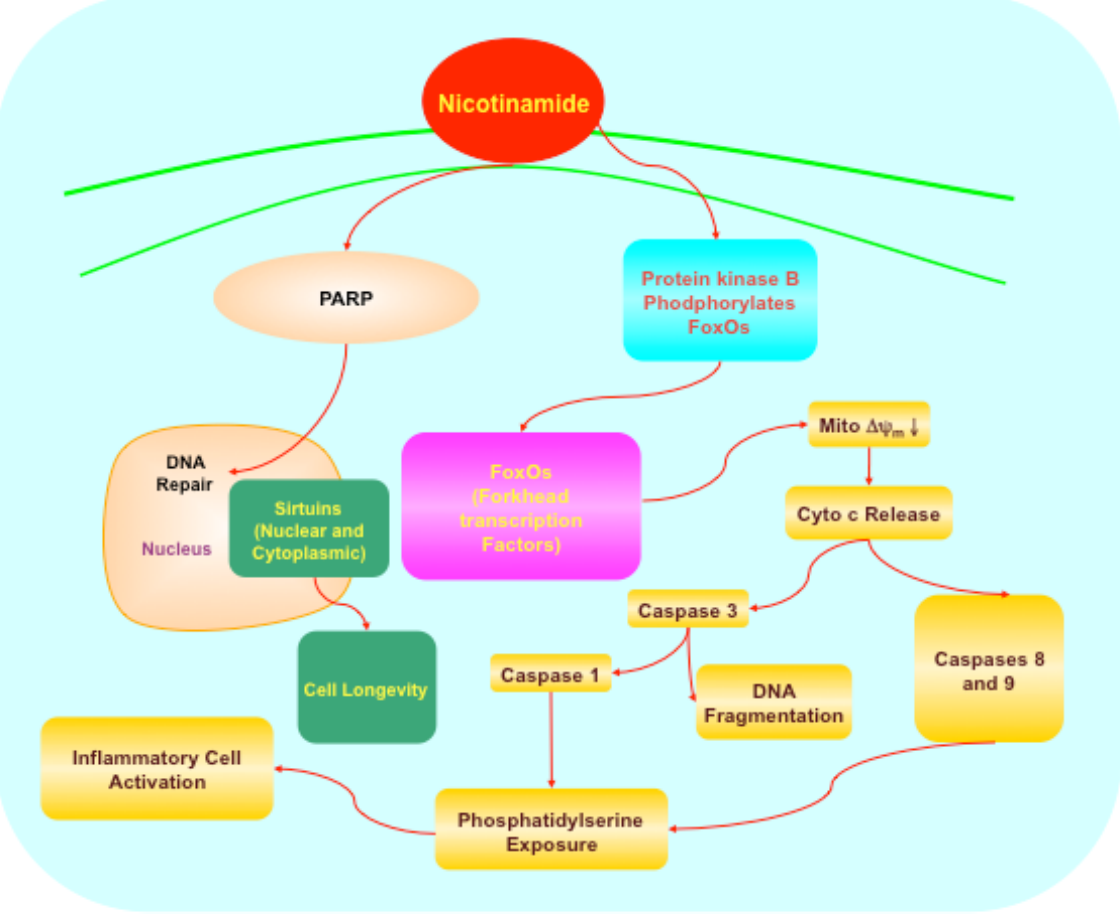
Figure 5. Nicotinamide relies upon novel cellular pathways to impact cell survival, longevity, and immune system function. Nicotinamide controls apoptotic early phosphatidylserine exposure, DNA repair and degradation, cell longevity, and immune cell activation through multiple pathways that involve modulation of sirtuin activity, protein kinase B (Akt), poly (ADP-ribose) polymerase (PARP), forkhead transcription factors, ), cytochrome c, (Cyto-c), and caspases 1,3, 8, and mitochondrial membrane potential (  m 9. These pathways can then regulate the onset of early apoptotic injury with phosphatidylserine exposure, late injury with nuclear DNA degradation, and inflammatory cell